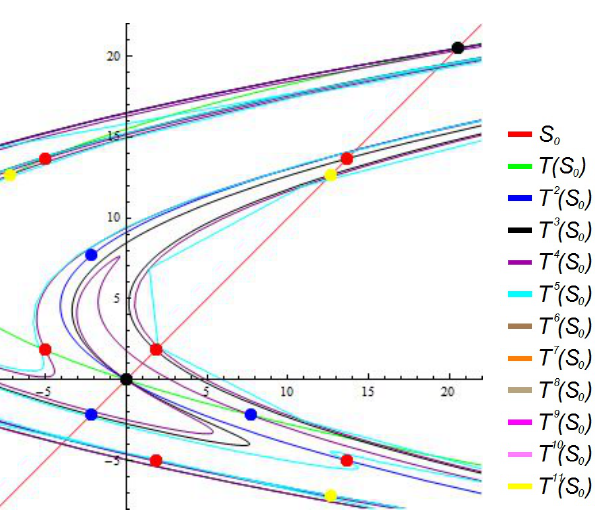
Figure 10. Period 3—Yellow and Blue and period 6—Red for α = − 2.1 (see Table